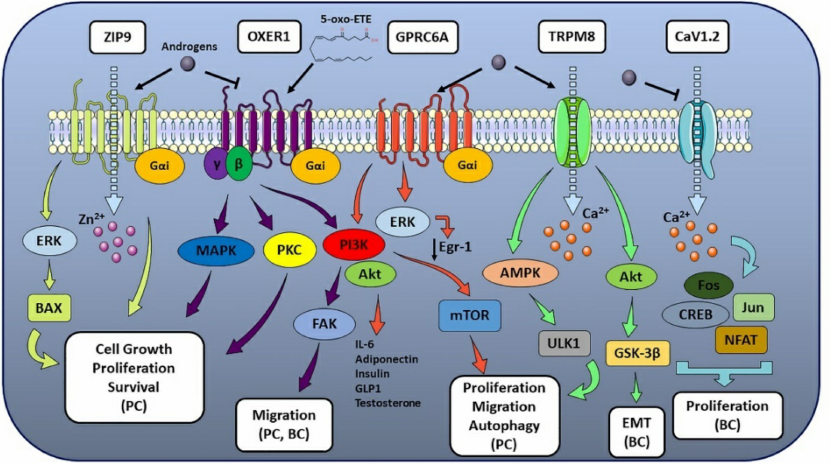
Figure 1. mAR-associated pathways and their effect on hormone-sensitive cancer progression. The figure illustrates the molecular pathways correlated to the different mARs and their biological effects on multiple hormone-sensitive cancer types. When one or more tumor-related processes were reported only for a specific cancer type, the latter was made explicit in the figure and put in parentheses (e.g., breast cancer as BC, prostate cancer as PC) (see text for